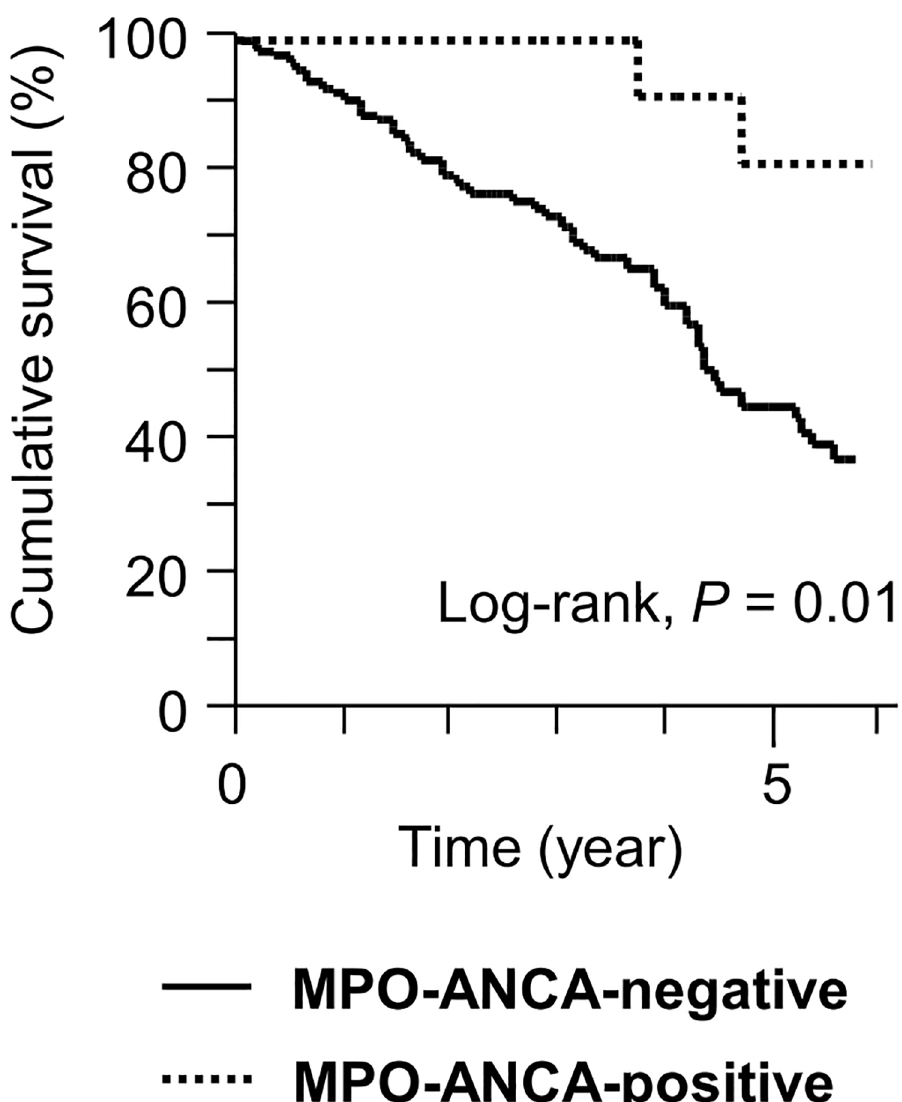
Fig 4. Cumulative survival rates of patients with the initial IPF diagnosis. The 5-year survival rate was 81.5% in the MPO-ANCA-positive patients, including patients who subsequently developed MPA, and 45.4% in the MPO-ANCA- negative patients. P = 0.01 by log-rank test. IPF, idiopathic pulmonary fibrosis; MPO-ANCA, myeloperoxidase-anti- neutrophil cytoplasmic antibody; MPA, microscopic